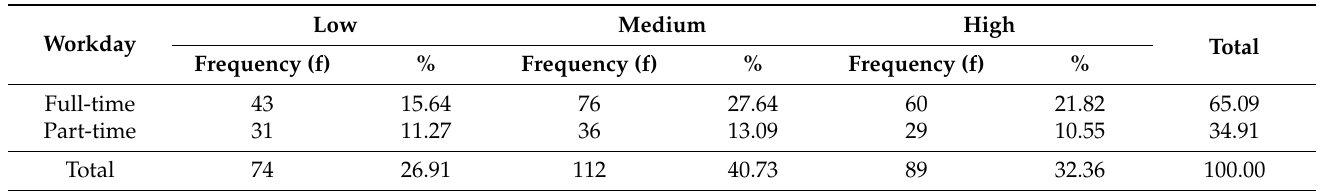
Table 8. Level of the remote work variable in Peruvian workers during the COVID-19 pandemic, according to the working day.